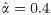
Influence of misfit of model parameters on beta values for the Rescorla-Wagner model.(A, B) The expected value of beta values in GLM 1 (A) and GLM2 (B), obtained using Eqs 39, 41 and 43. The fit learning rate used for the simulation in Fig 2, α^=0.4, is indicated by the solid vertical lines. (C, D): The standard deviation of beta values in GLM 1 (C) and GLM2 (D). These are obtained by taking the square root of Eqs 40, 42 and 44. (E, F): The effect size (d1; for single group) of beta values in GLM 1 (E) and GLM2 (F). In all panels, the red lines represent the results for the true learning rate α = 0.2 and blue lines represent α = 0.4. In panel A, C, and E, these lines represent the results of the regression coefficient of RPE, βδ. In panel B, D, and F, they represent the results of the regression coefficient for negative values, βNV. Broken bold lines indicate the results of regression coefficient for reward, βr.